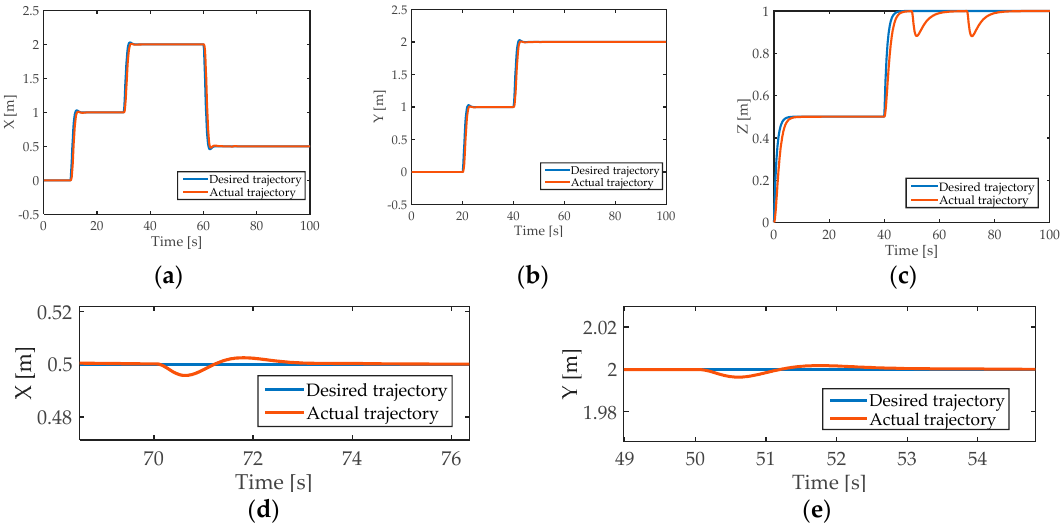
Figure 7. Tracking performance in three positions: ( a ) x -direction; ( b ) y -direction; ( c ) z -direction; ( d ) zoomed x -direction at 50 s; ( e ) zoomed y -direction at 70 s.